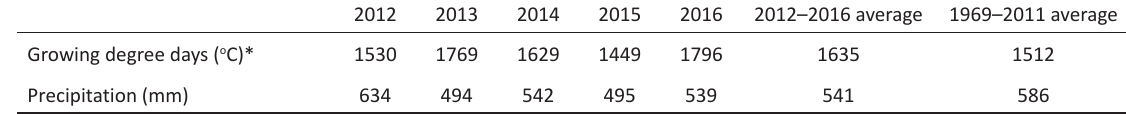
Table 2. Temperature and precipitation during experiment years and long-term